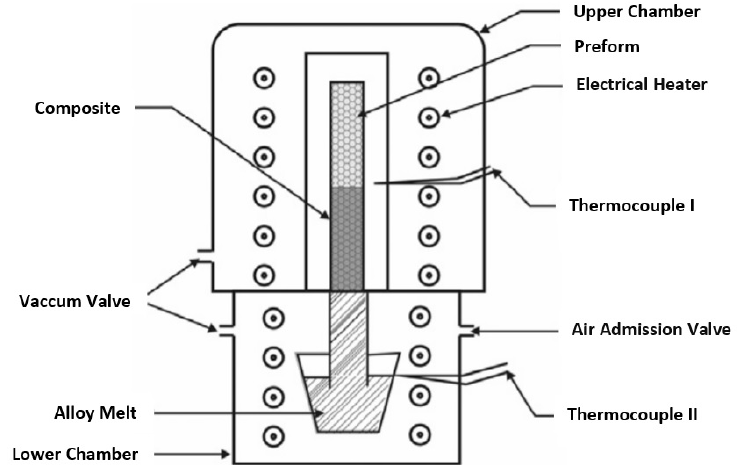
Figure 13. Schematic diagram of the gas pressure infiltration apparatus [142].